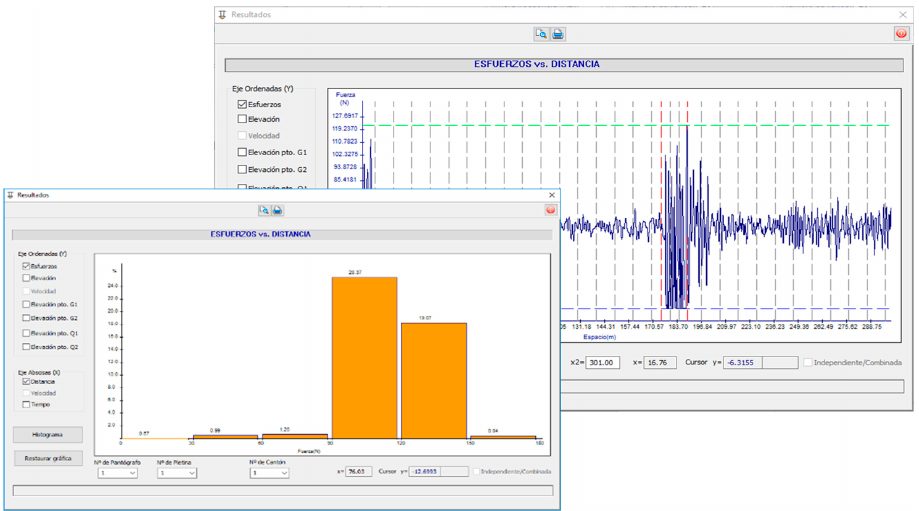
Figure 9. Graphical results of the RICATI application.